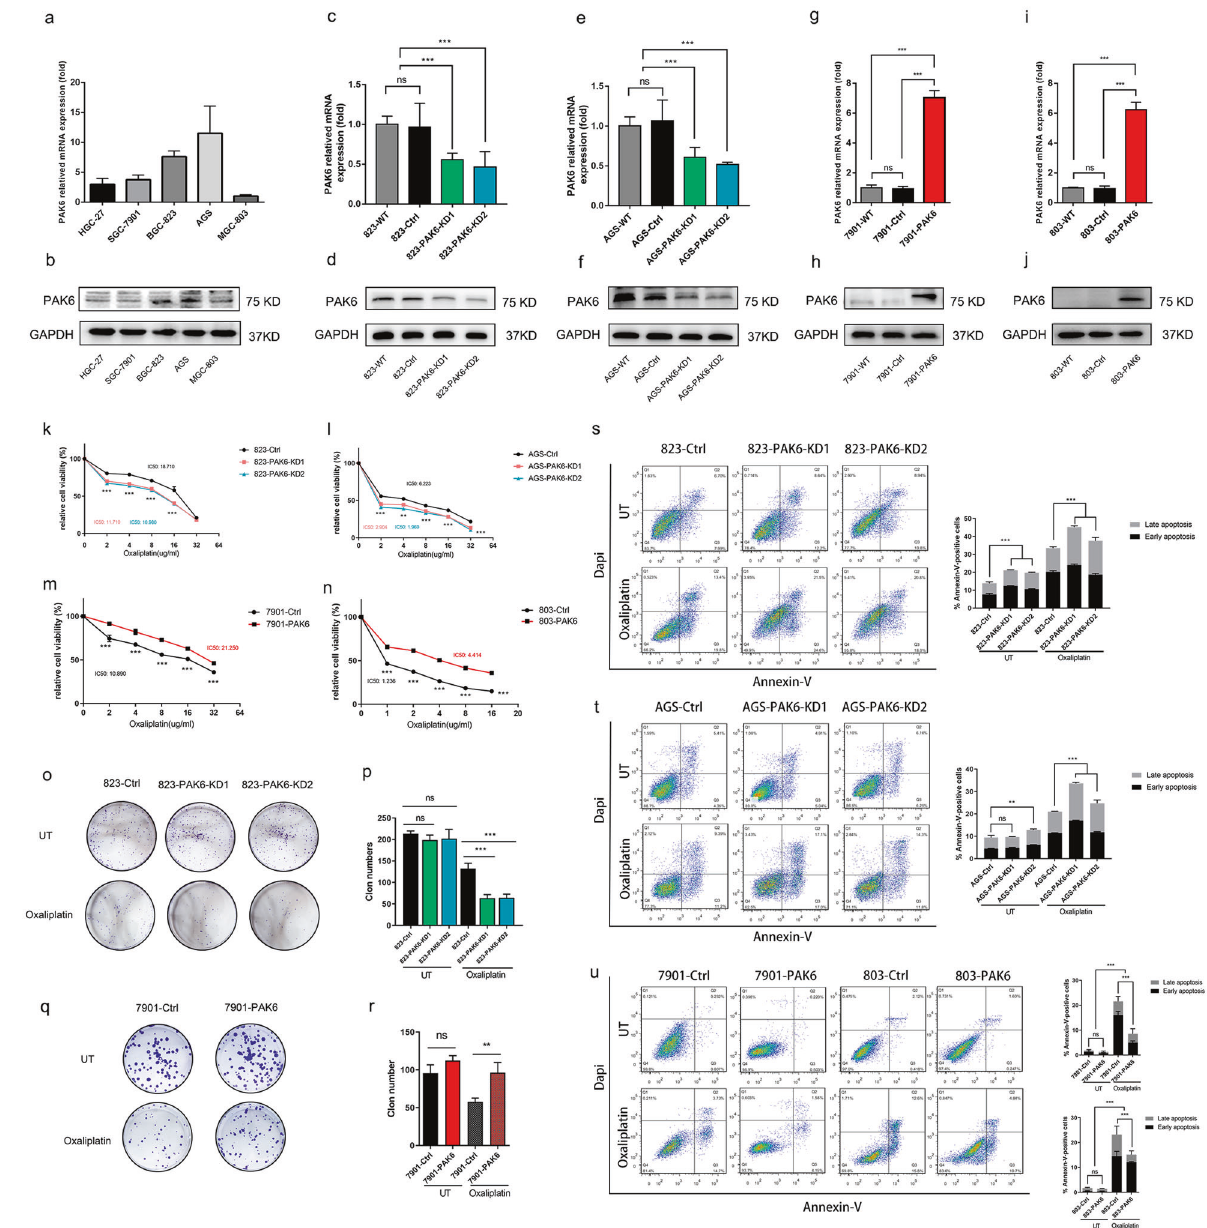
Fig. 2 PAK6 increases the chemoresistance to oxaliplatin in GC cells. a , b The expression of PAK6 in HGC-27, SGC-7901, BGC-823, AGS, and MGC-803 GC cell lines. c – f Knock down of the expression of PAK6 in 823 ( c , d ) and AGS ( e , f ) GC cells. g – j Overexpressing the expression of PAK6 in 7901 ( g , h ) and 803 ( i , j ) GC cells. k – n Dose-response curves of control cells or PAK6 knocked down cells in 823 ( k ) and AGS ( l ) GC cells after treated with oxaliplatin for 24 h. The IC 50 of the oxaliplatin in the 823 cell line are 18.701(823-Ctrl cells), 11.710 (823-PAK6-KD1 cells), and 10.960 (823-AK6-KD2 cells) μ g/ml. The IC 50 of the oxaliplatin in the AGS cell line are 6.233 (AGS-Ctrl cells), 2.904 (AGS-PAK6-KD1 cells), and 1.969 (AGS-PAK6-KD2 cells) μ g/ml. Dose-response curves of control cells or PAK6 overexpression cells in 7901 ( m ) and 803 ( n ) GC cells after treated with oxaliplatin for 24 h. The IC 50 of the oxaliplatin in the cells are 10.890 (7901-Ctrl cells), 21.250 (7901-PAK6 cells), 1.236 (803-Ctrl cells), and 4.414 (803-PAK6 cells) μ g/ml. o – r Colony formation ability of PAK6 knocked down cells in 823 GC cell line ( o , p ) and PAK6 overexpression cells in 7901 ( q , r ) GC cell line treated with or without oxaliplatin (0.3 μ g/ml in 823 cells or 0.5 μ g/ml in 7901 cells). s , t Apoptosis analysis of control cells and PAK6 knocked down cells in 823 and AGS GC cells treated with or without oxaliplatin. u Apoptosis analysis of control cells and PAK6 overexpression cells in 7901 and 803 GC cells treated with or without oxaliplatin. Data presented as mean ± SD of three independent replicates. *: P < 0.05, **: P < 0.01, ***: P < 0.001, ns: no statistical difference. oxaliplatin in 803 cells, indicating PAK6 might mainly affect HR Increasing studies have revealed that HR is the main pathway repair (Fig. S4a – f). Further, the fi nding was further validated involved in DNA repair after treatment of anti-tumor agents [18]. through plasmid-based HR repair reporter assay on HEK-293T cells. Therefore, the present study hypothesized whether PAK6 affects In this study, I-SceI plasmid was transfected into 293T-HR-EGFP- the HR repair to improve the chemoresistance to oxaliplatin. PAK6 cells and 293T-HR-EGFP-Vec cells to induce DSBs. Enhanced Notably, cell cycle analysis showed that the G2/M cell cycle arrest green fl uorescent protein would be expressed if the damaged in PAK6 overexpression cells followed by the treatment of Cell Death and Disease (2022)